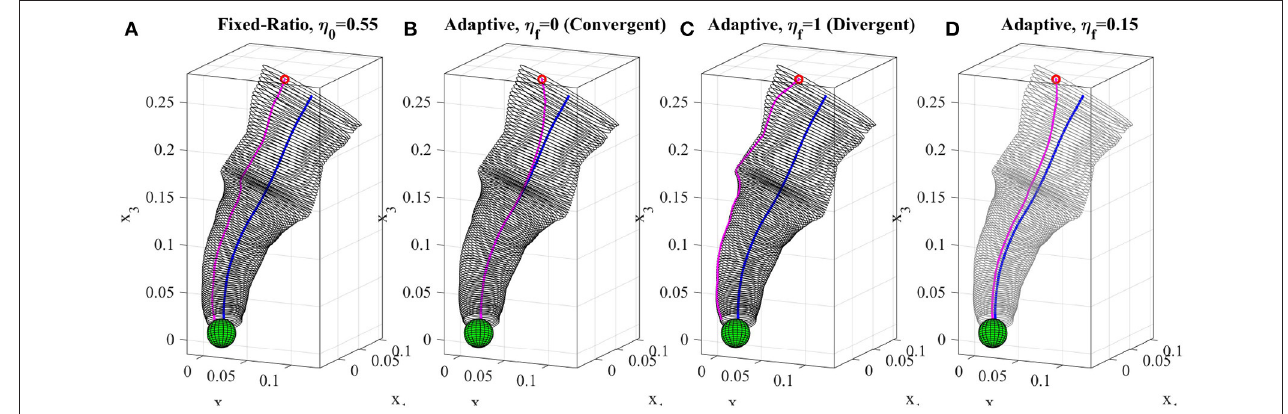
FIGURE 7 | Reproduction of the reaching skill using different reproduction strategies (section 4.2). (A) fixed-ratio rule with η 0 = 0.55, (B) adaptive-ratio rule with η f = 0 (i.e., convergent), (C) adaptive-ratio rule with η f = 1 (i.e., divergent), (D) adaptive-ratio rule (in dark green) with η 0 = 0.55 and η 0 = 15. The directrix and the reproductions are depicted in blue and magenta respectively. All trajectories were reproduced from the same initial